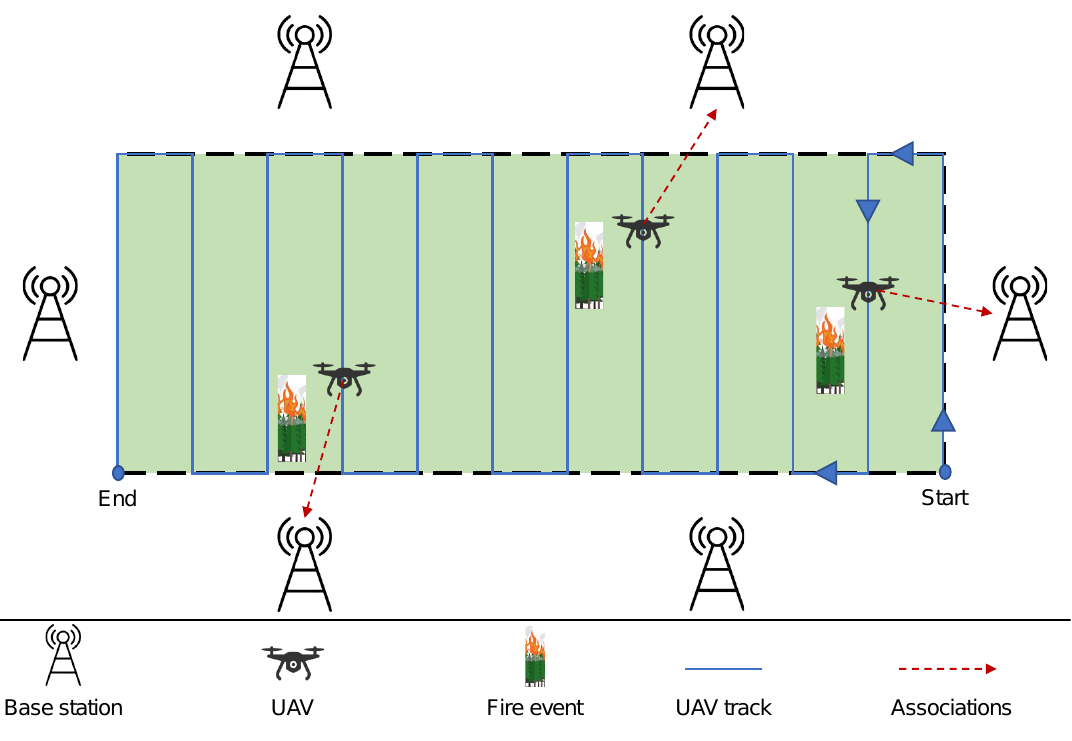
Figure 1. System